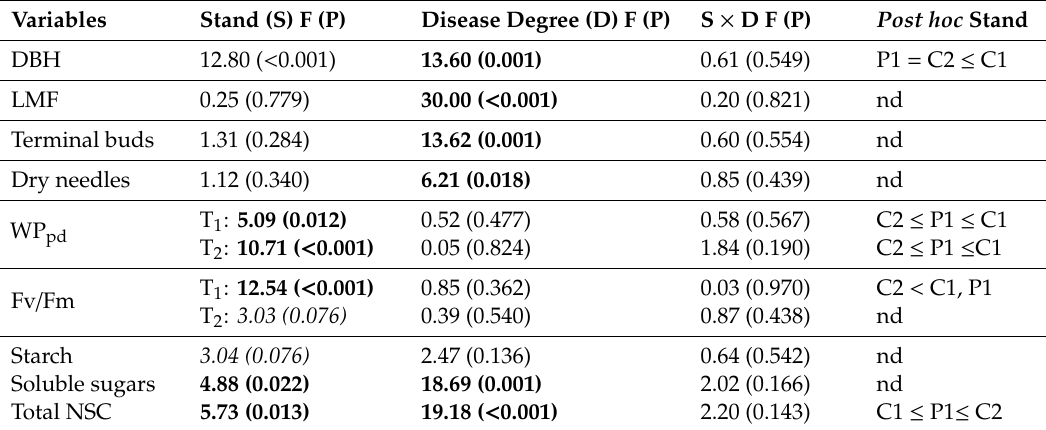
Figure 6. Proportion of dry needles versus normal needles per branch (%), measured in each pine stand and disease degree. The striped dark gray bars show the values for the NA-trees; the smooth